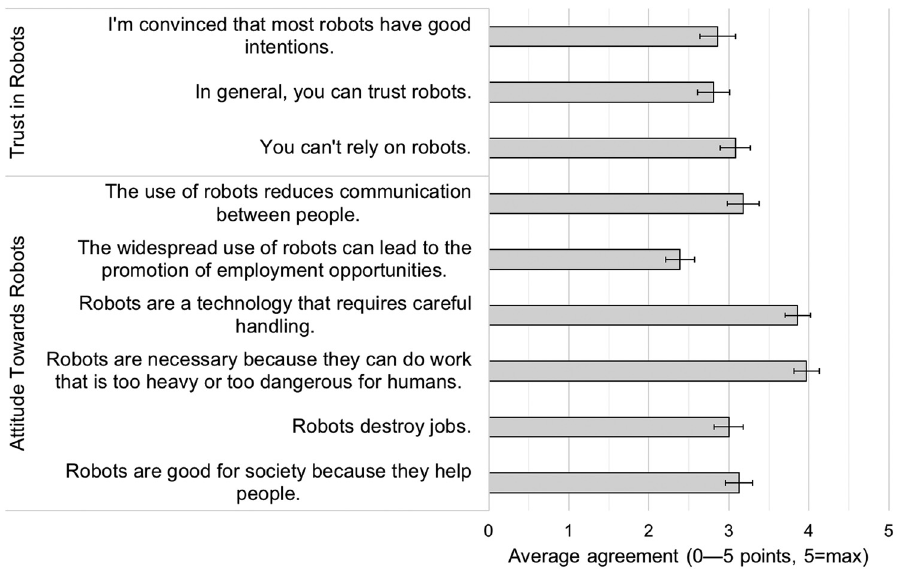
Figure 3: Attitude toward robots and trust in robots ( mean values with 95% con fi dence interval )